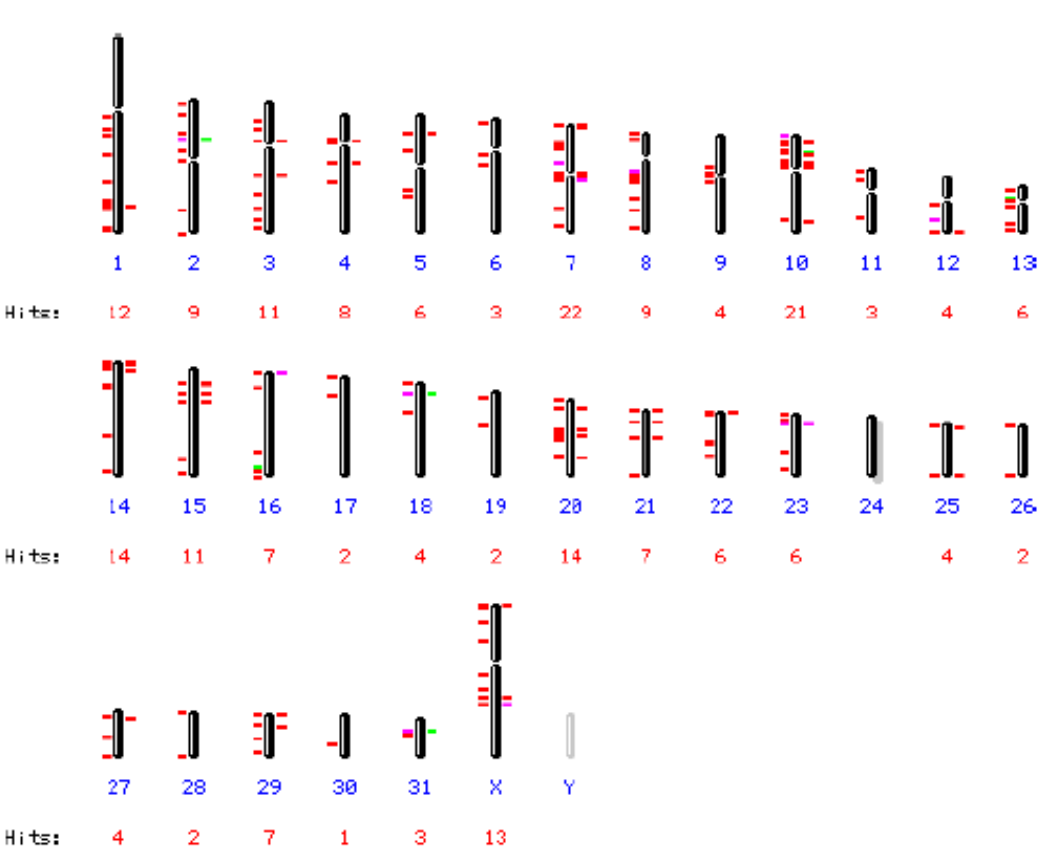
motif. This fragment is identical to unpublished equine DNA fragments labeled equine microsatellite DNA (e.g., Genbank acc. no. FN419635), but is also part of other, related proviral structures on E. caballus chromosomes 7 and 20 which contain an identical 5’ LTR + PBS(Lys3) upstream of a same repeat segment (BLAST result not shown, sequence identity 96–98%, 1–2% gaps). Also, a putative second EqERV-beta1 provirus on chromosome 5 with 99.6% homology also possesses this structure downstream of its 5’ LTR. This suggests that the repeat fragment is not an artifact of this specific integration, but has indeed been part of the replicating virus genome. In MMTV, the region between PBS(Lys3) and the gag startcodon is much shorter (around 160 nt in GenBank acc. no. AF228552 that contains full-length LTRs), and very T-rich, but contains no simple repeats. Figure 2. Distribution of EqERV-beta1 long terminal repeat (LTR) sequences over the horse chromosomes. NCBI Map Viewer output of a BLAST search of the horse ( Equus caballus ) genome (2N = 64) with the EqERV-beta1 LTR as query sequence. Chromosome numbers (blue) and hits per chromosome are indicated. Only 15 of 227 LTRs, distributed over 10 chromosomes, did not correspond to a full-length LTR or showed a lower sequence homology (generally 85–89%, indicated with a green or pink line), while most integrations were >95% homologous to the query sequence (indicated with a red line).